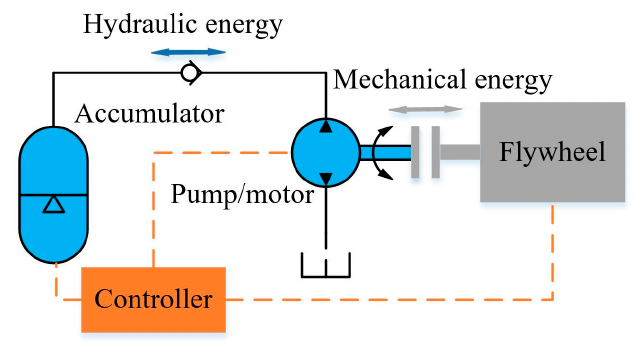
Figure 2. Structure and operational principle of the regenerative braking system.